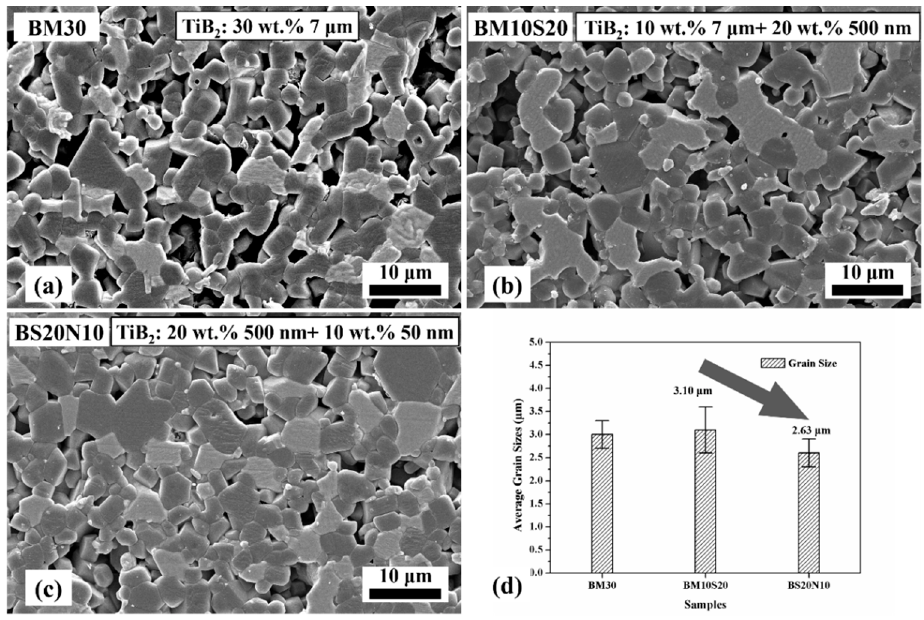
Figure 6. SEM images of the polished surfaces ( a ) and corresponding BSE images ( b ) in the sample.